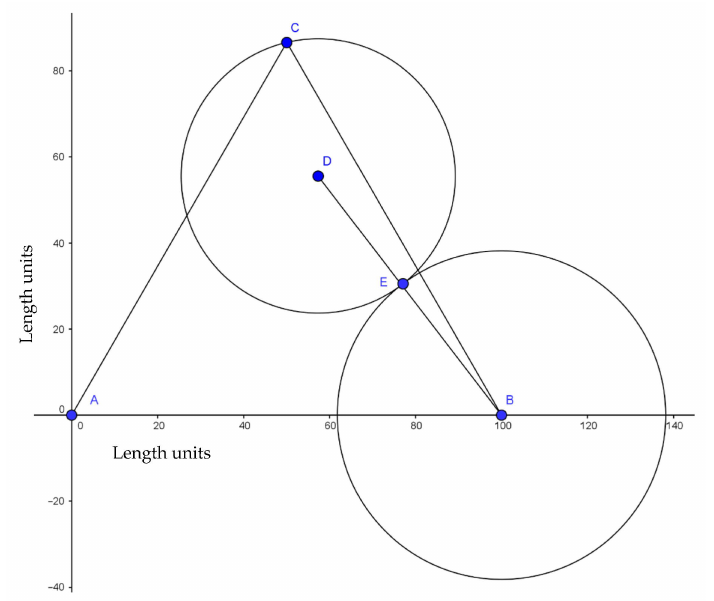
Figure 7. Location of Point E, set by the delay between the excitation time in Sensors C and B.